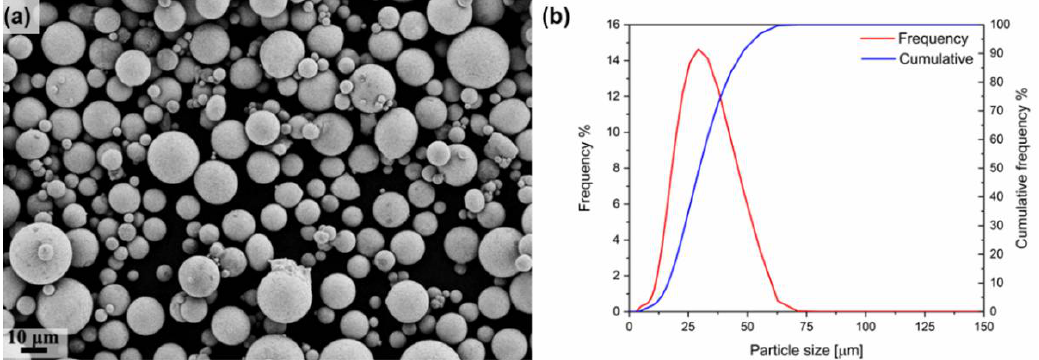
Figure 1. ( a ) Morphology of the tin bronze powder. ( b ) Particle size distribution of the tin bronze powder. Table 1. Measured and declared chemical compositions of Cu-10Sn alloy.